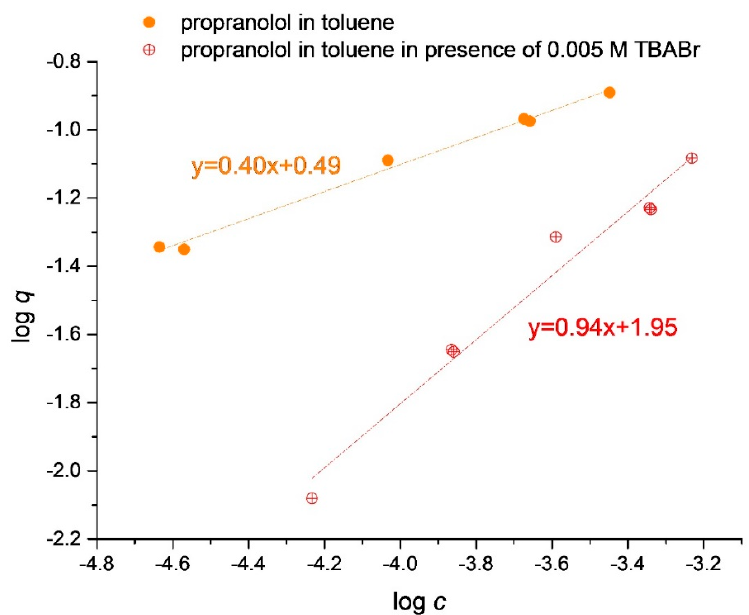
Figure 1. Adsorption isotherms of propranolol on the propranolol imprinted polymer (MIP) measured in toluene.